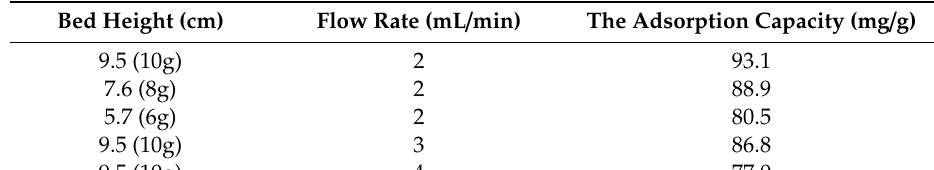
Table 3. E ff ect of bed height and flow rate on the column adsorption capacity of the mixture adsorbent (CCSP2 and AC) to treat the textile wastewater.